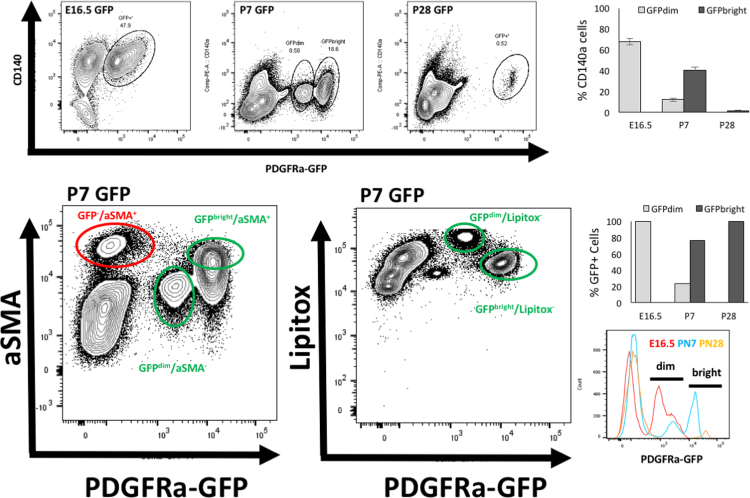
Assessment of PDGFRα-GFP interstitial fibroblasts for PDGFRα-GFPdim and PDGFRα-GFPbright subpopulations. Flow cytometry profiles of PDGFRαGFP dim and bright sub-populations throughout acinar lung development. (A) Relative proportions at E16.5, P7, and P28 of PDGFRα-GFPdim and PDGFRα-GFPbright subpopulations. (B-C) Contribution of αSMA+ myofibroblasts (B) and LipidTOX+ lipofibroblasts (C) to the discernible PDGFRα-GFPdim and PDGFRα-GFPbright subpopulations that comprise the pool of P7 PDGFRα-GFP interstitial fibroblasts. (E) Quantification of GFPdim and GFPbright in CD140 positive cells. (F) Quantification of GFPdim and GFPbright in all GFP positive cells. (F) Histogram overlay of GFP intensity in E16.5, PN7 and PN28 GFP cells.